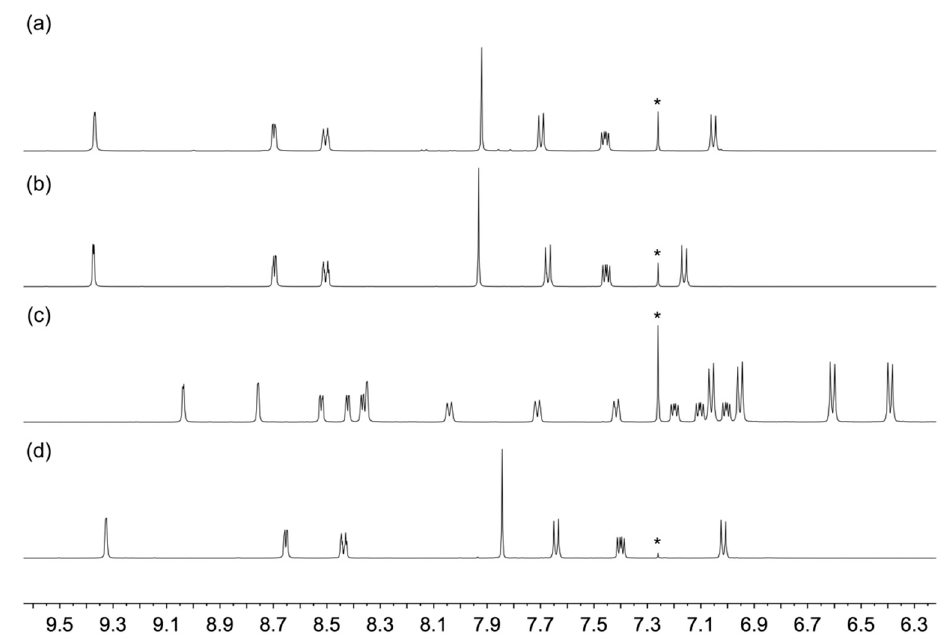
Figure 2. Comparison of the aromatic regions of the 1 H NMR spectra (500 MHz, 298 K, CDCl 3 ) of ( a ) rac - 2 , ( b ) 4 , ( c ) 3a and ( d ) 3 . * = residual CHCl 3 .